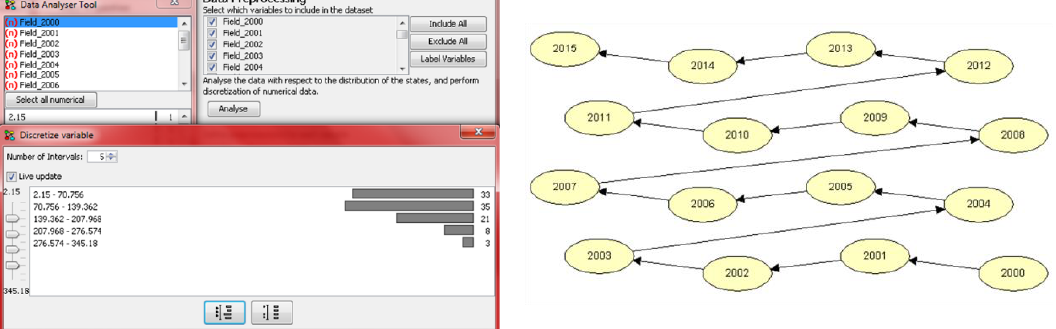
Figure 8. Conceptual design of BCM. ( Left ) Schemes of learning, preprocessing, and structure constraints processes. ( Right ) Hierarchical structure from top to bottom (from initial year to final one).